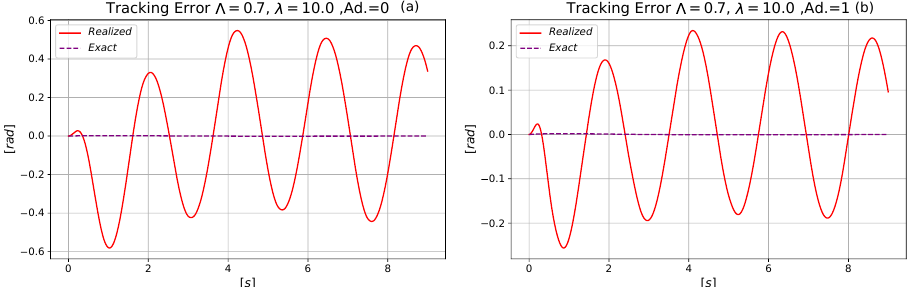
Figure 10. Trajectory tracking for the small amplitude and high circular frequency of the nominal trajectory for which the adaptive controller was able to use only the originally learned data. ( a ): Non- adaptive, ( b ): adaptive control.